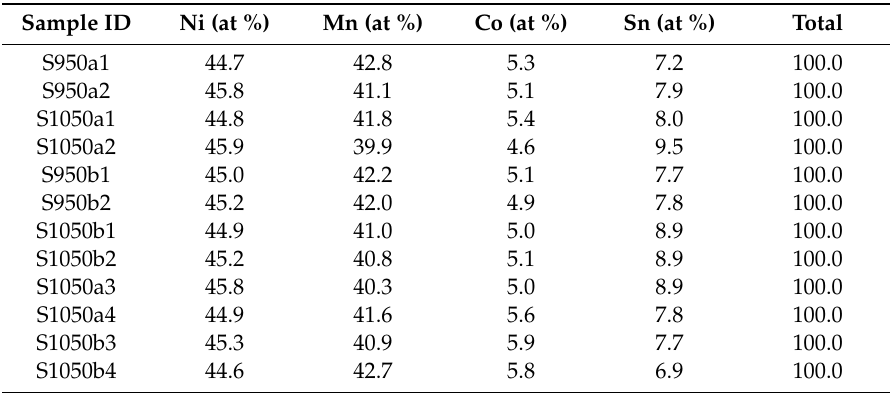
Table 3. Composition of the alloys obtained from EDS.